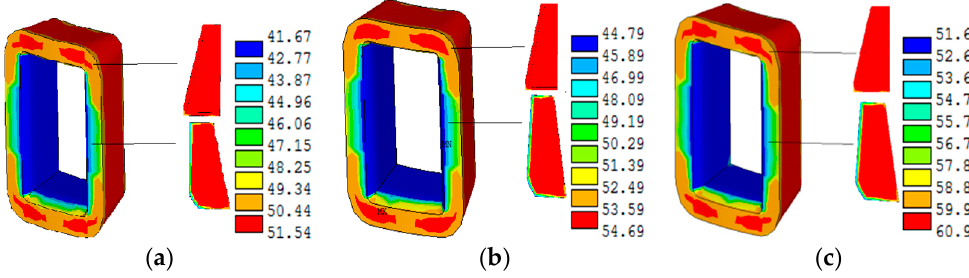
Figure 14. Temperature distributions of the armature windings under different AMMF (°C); ( a ) 0 At AMMF; ( b ) 600 At AMMF; and, ( c ) 900 At AMMF.